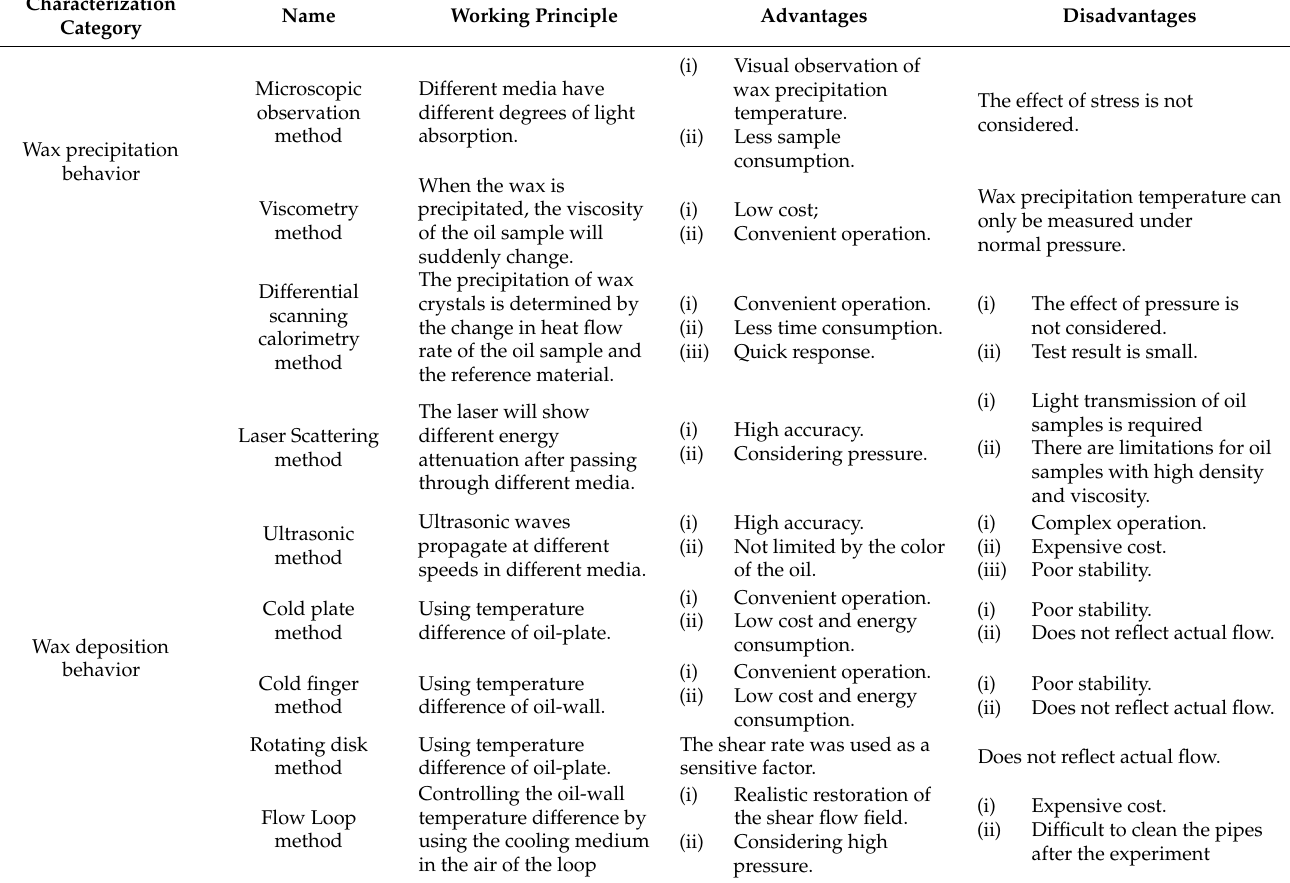
Table 3. Experimental methods of characterization wax precipitation and